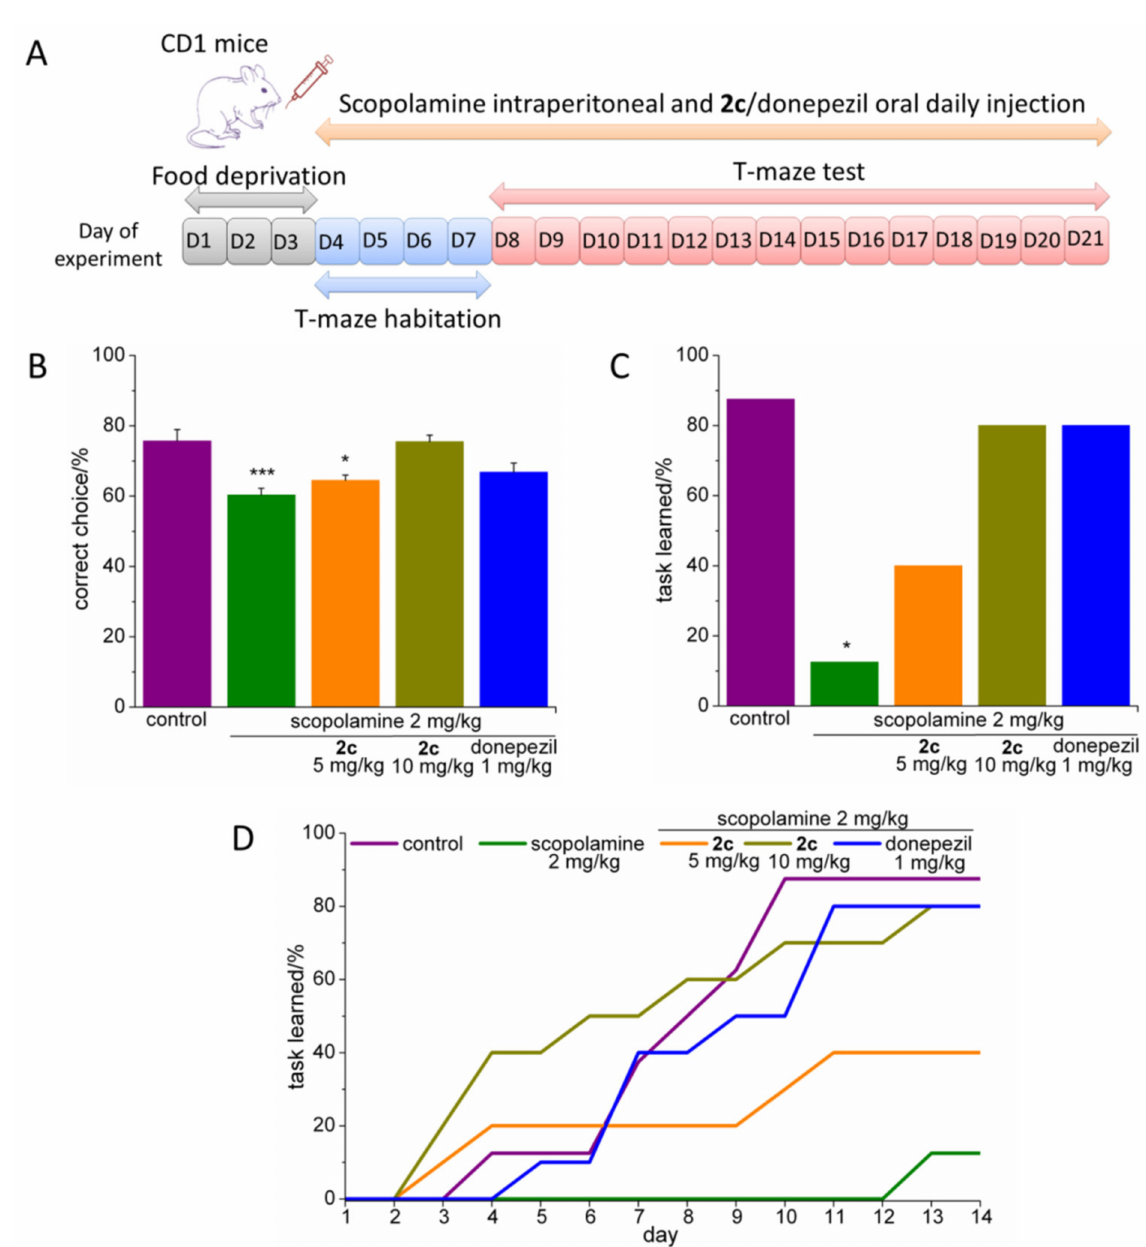
Figure 6. Effect of compound 2c and donepezil on spatial memory performance in T-maze test in a scopolamine-induced amnesia model. ( A ) Experimental paradigm: CD1 mice were treated with scopolamine (2 mg/kg) and either compound 2c (5 or 10 mg/kg) or donepezil (1 mg/kg) within 18 days during the T-maze test. ( B ) Percentage of correct choices in the T-maze test. Data are reported as mean ± SE. Statistical analysis was performed using the Mann–Whitney test. ( C ) Percentage of mice reaching the criterion of learning the task by day 14 in the T-maze test. Statistical analysis was performed using Fisher’s exact test. ( D ) Dynamic of reaching the criterion of learning the task. * p < 0.05, *** p < 0.001 compared to control